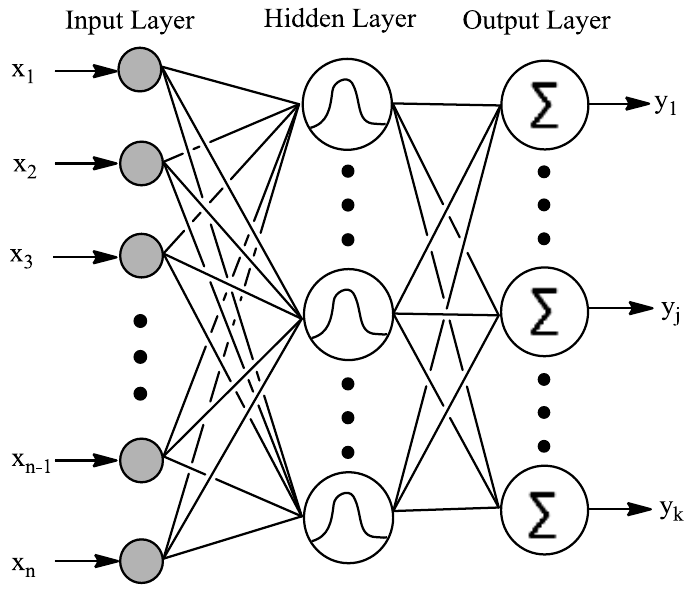
Figure 10. General structure of radial basis function (RBF) networks.